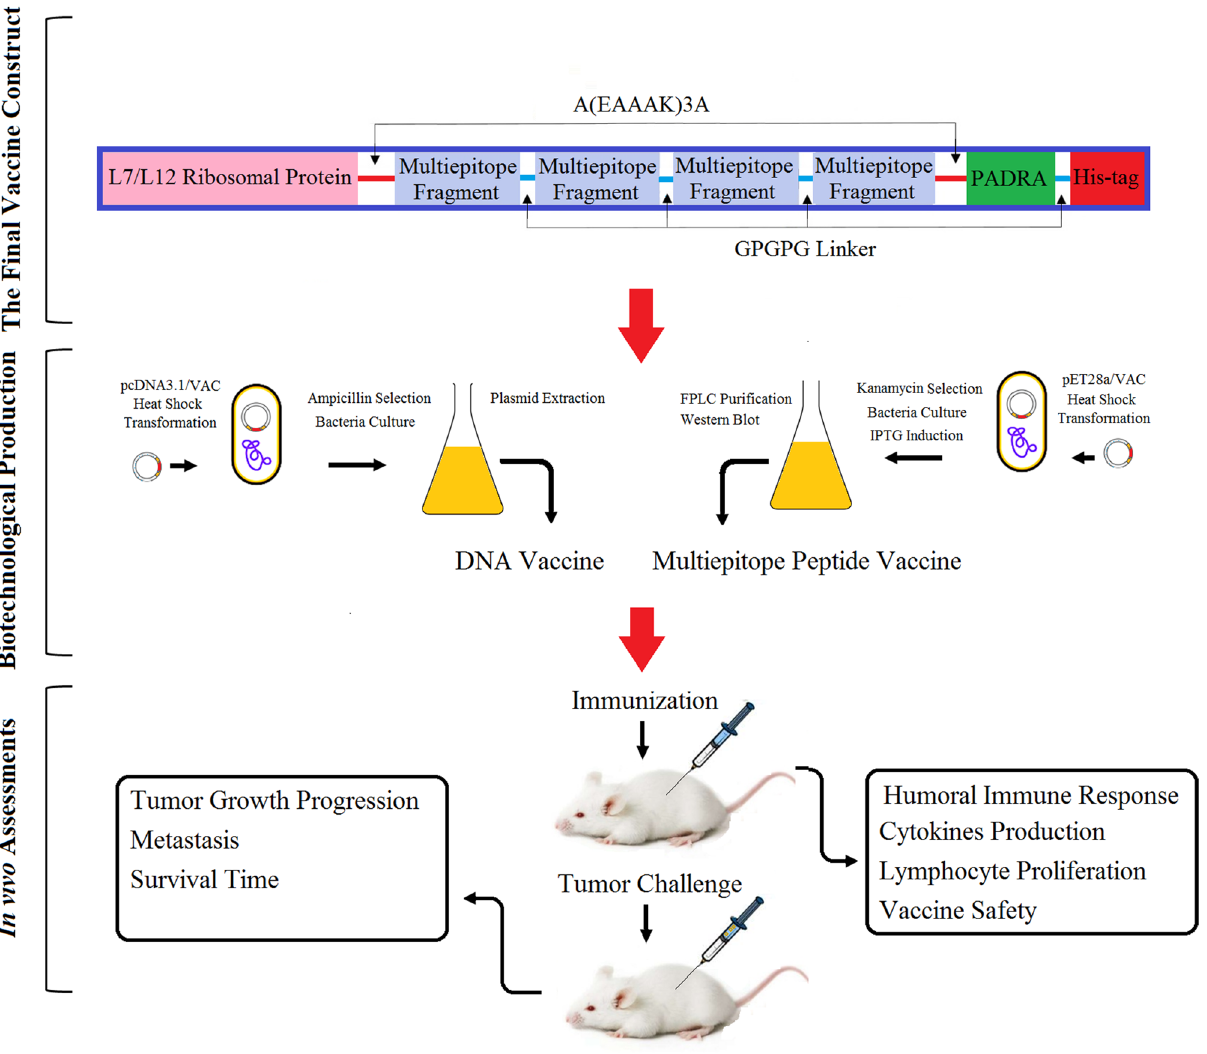
Figure 1. Schematic illustration of the multiepitope peptide vaccine construct and study steps including multiepitope peptide and DNA vaccines production, purification, and in vivo assessment of its immunoprotective effects in a non-immunogenic metastatic murine breast cancer